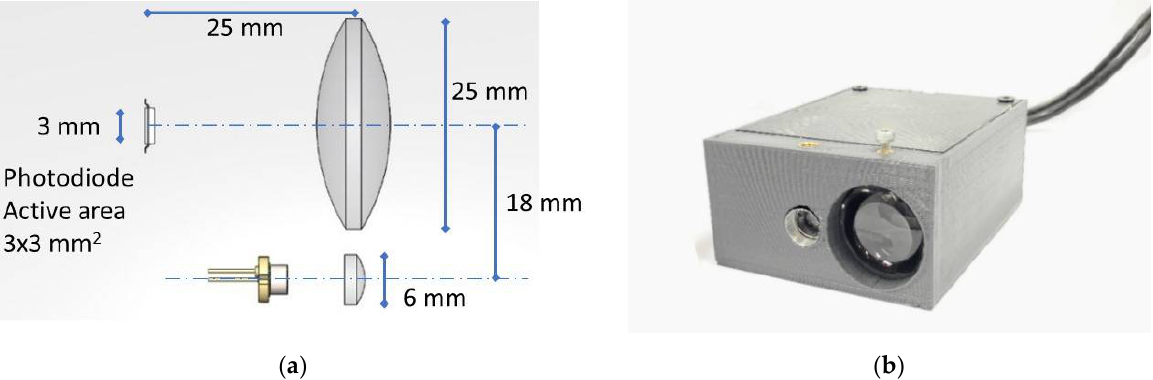
Figure 3. ( a ) The optical setup is composed of laser diode, transmitter lens, photodiode, and receiver lens. the ( b ) Photo of pulse amplitude estimation algorithm based on the double-side digital baseline restorer.